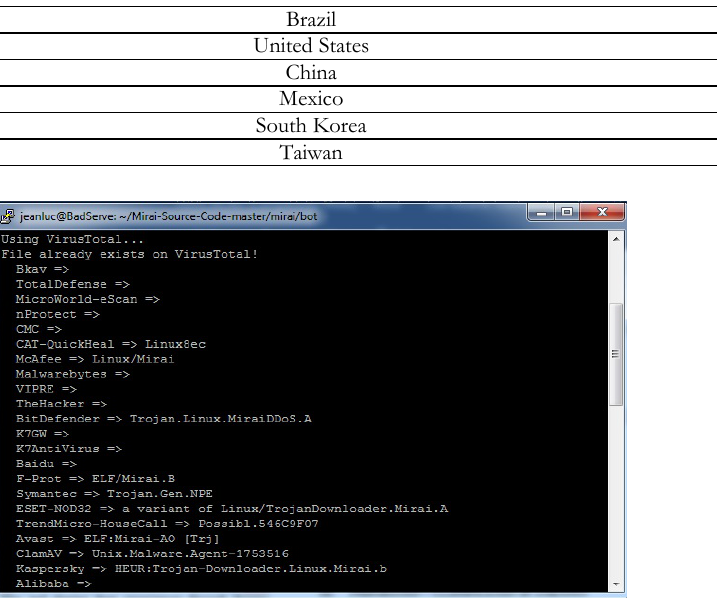
Figure 2. Output generated by avsubmit.py Table 2. Mirai shellcode